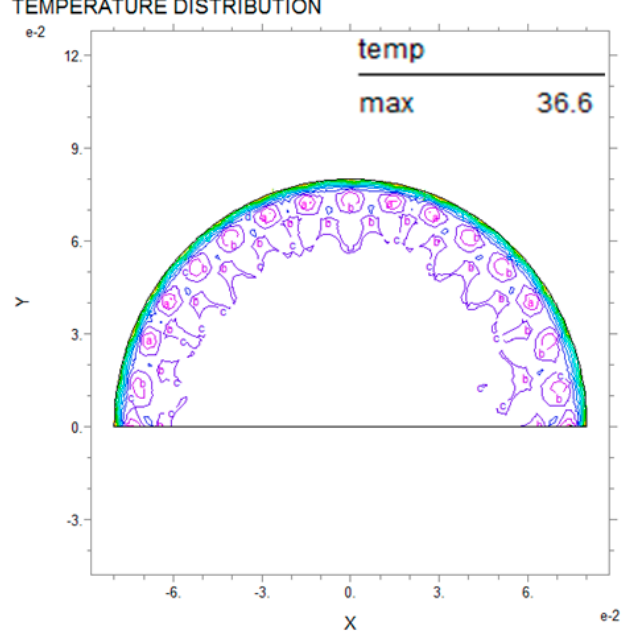
Figure 8. PDE thermal analysis at R1 = 80 mm, R2 = 3 mm.